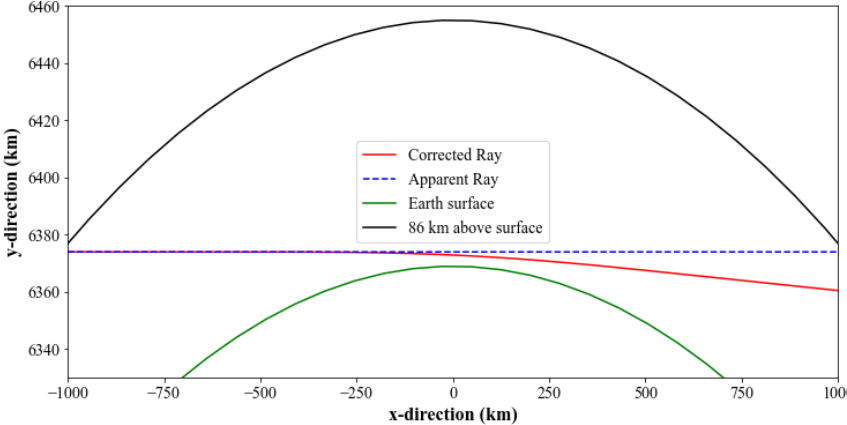
Figure 1. Example of ray trajectory through an atmospheric profile from MERRA2. The black and green lines do not look circular because of the different x and y scales. Ray tracing computes both the ray perigee and the bending angle for an apparent ray. Here, an apparent ray perigee of 5km results in a corrected ray perigee of 3.77km with 2914arcsec bending